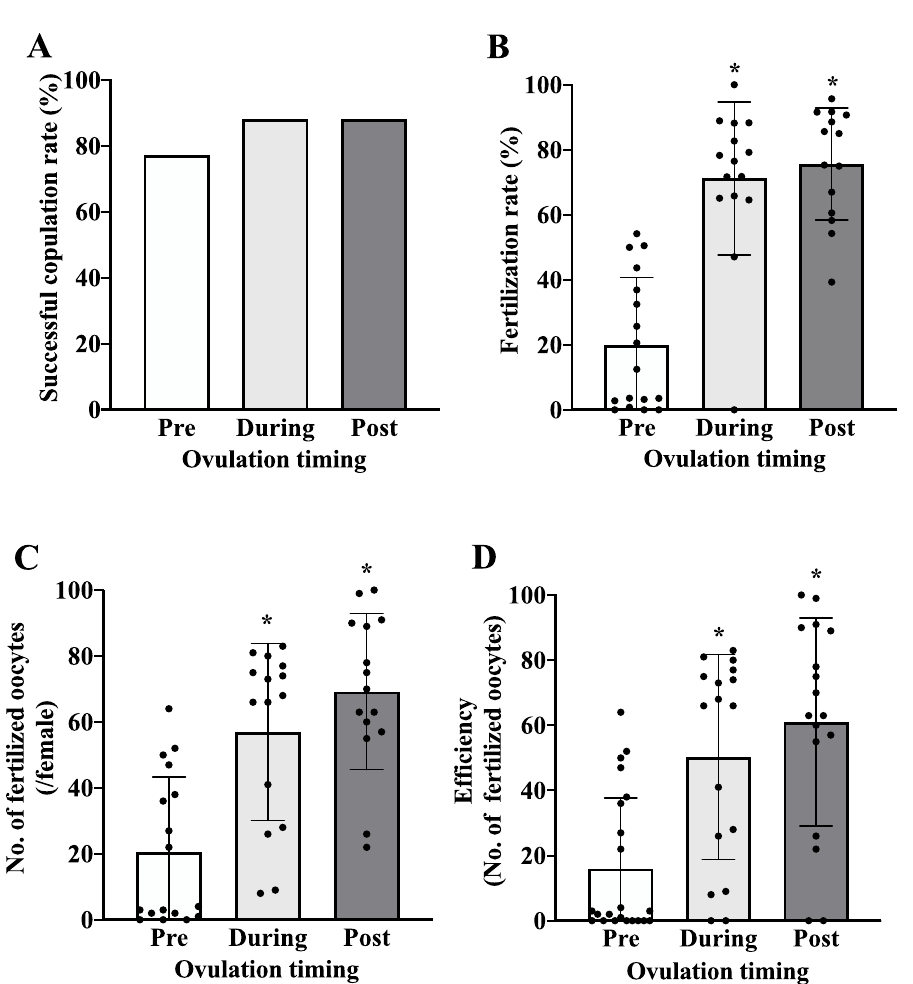
Fig 1. Effect of synchronizing the timings of ovulation and copulation on the fertilization rate in vivo . Female mice (4 weeks old) treated with IASe were divided into three groups: pre ovulation (0–10 h after hCG injection), during ovulation (10–15 h after hCG injection), and post ovulation (15–19 h after hCG injection). These female mice were then copulated with male mice in each period. (A) The successful copulation rate was calculated using the following equation: Successful copulation rate (%) = total number of plugged female mice / total number of female mice used for copulation × 100. (B) The fertilization rate was calculated using the following equation: fertilization rate (%) = total number of two-cell embryos / total number of collected oocytes and two-cell embryos × 100. (C) The average number of fertilized oocytes obtained from each female mouse with a plug. (D) The efficiency was the average number of fertilized oocytes obtained from each female mouse used for copulation. Values are presented as the mean ± SD (n = 15–21). � p < 0.05 compared with pre ovulation.